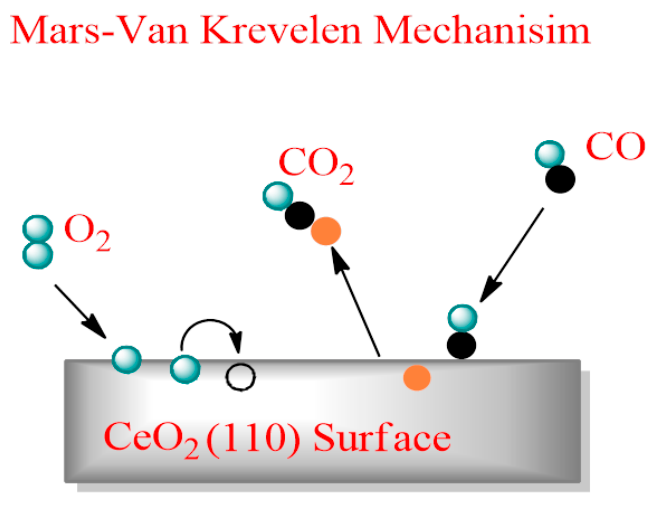
Figure 9. Schematic illustration of the CO oxidation over CeO 2 (110) surface via Mars-van Krevelen mechanism [148].